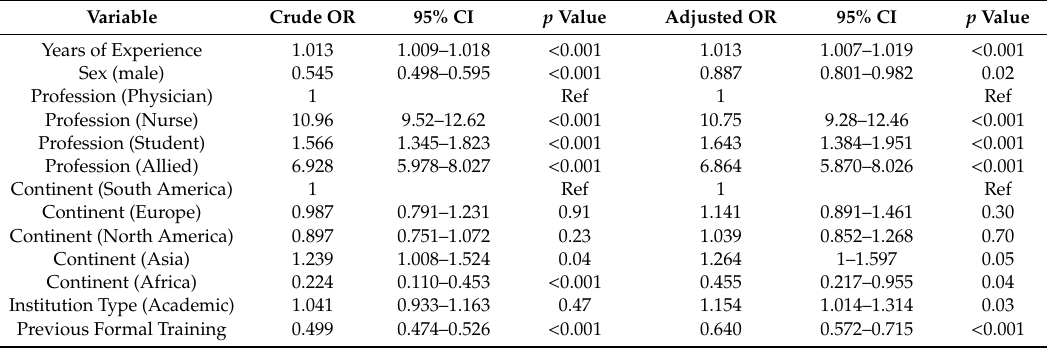
Table 2. Factors associated with reporting leaving breaking bad news to someone else in a multivariable logistic regression